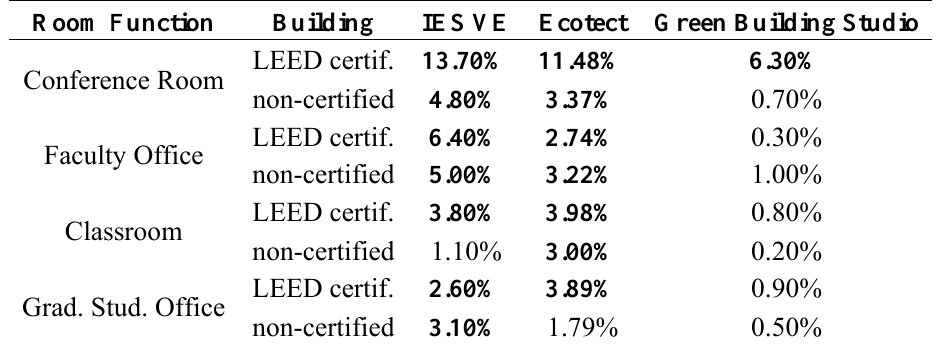
Table 3. Comparison of daylight factors (for the selected rooms and the three building energy modeling (BEM) software). Bolded values are greater than the minimum required daylight factor (2%) for adequate